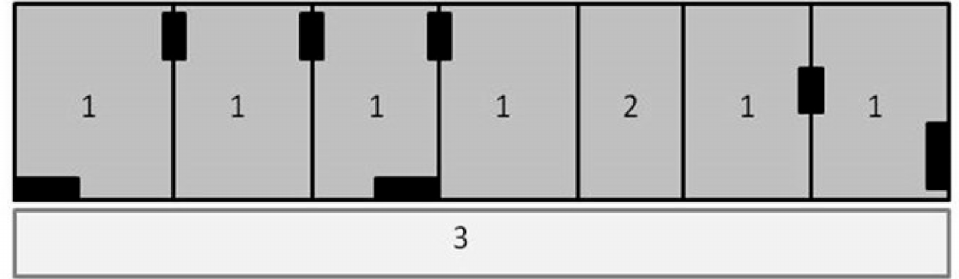
Figure 1. Top view of lesser anteater enclosures and laboratory: 1 represents the enclosures where the individuals were kept; 2 represents the laboratory in which an area was conditioned (evaluation room) to carry out the behavioral evaluations, and 3 represents the public view. Wire gates (smaller black rectangles) connecting enclosures and glass gates (larger black rectangles) to enter the enclosures are shown. There was an enclosure that housed 2 lesser anteaters, a mother and her sub-adult